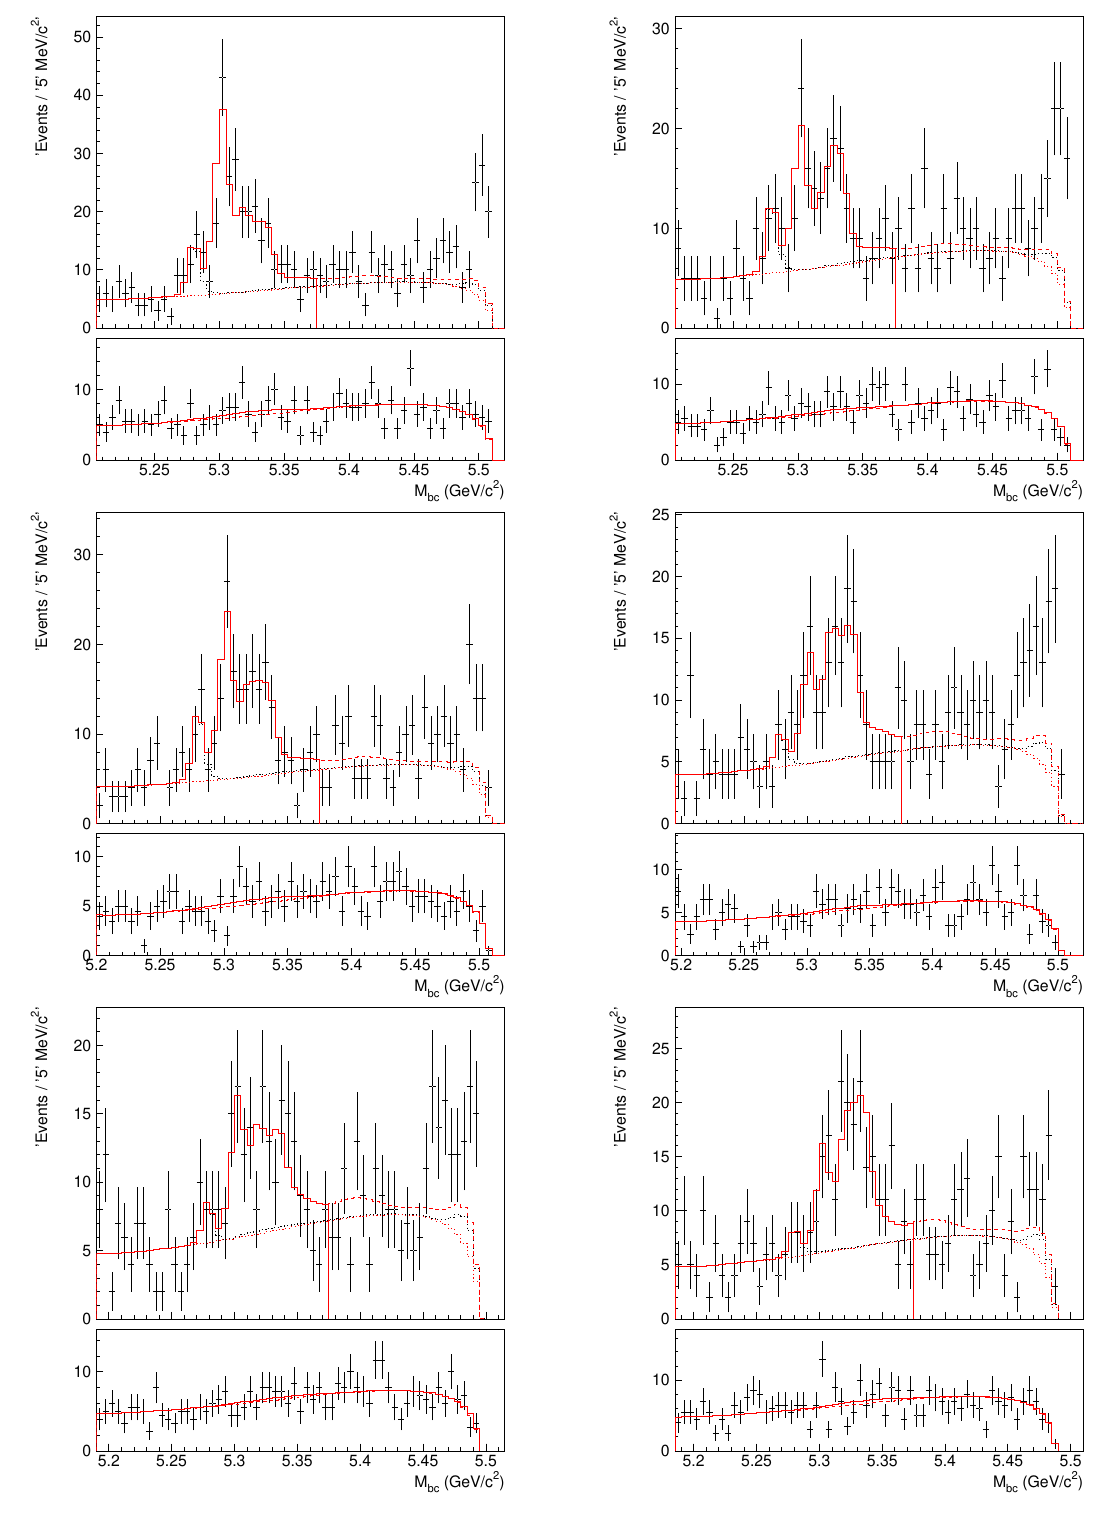
Figure 14 . The M bc distributions for the points 1 to 6 in table 5 (from left to right and from top to bottom). Legend is the same as in figure